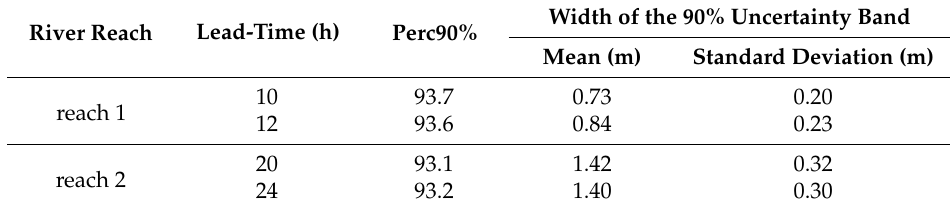
Table 3. Polavaram section (MCP-MT calibrated considering all the available dataset): percentage of observed data that fall inside the 90% uncertainty band (Perc90%), and mean and standard deviation of the uncertainty band width.